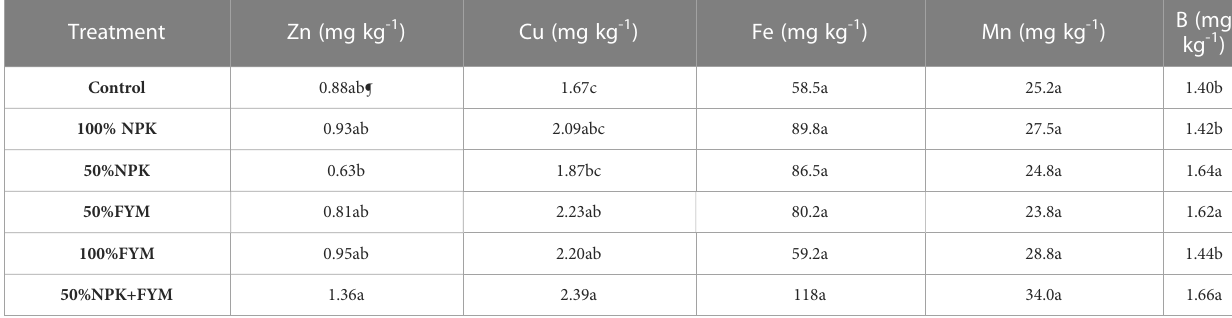
TABLE 3 Effect of long-term fertilization and manuring on soil micro-nutrients.